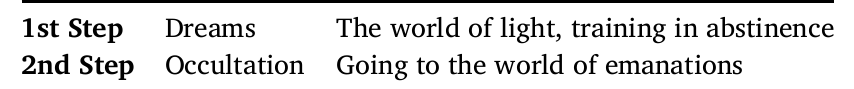
Table 5 Āẕar Kaivān’s mystical four steps in Ğām-e Kai Ḫosro